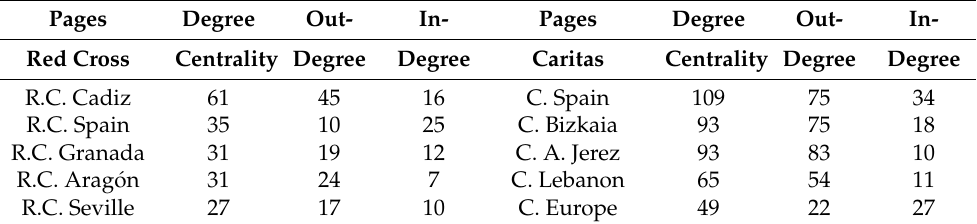
Table 4. The five most influential Facebook pages in the networks of Red Cross Cadiz and Caritas.